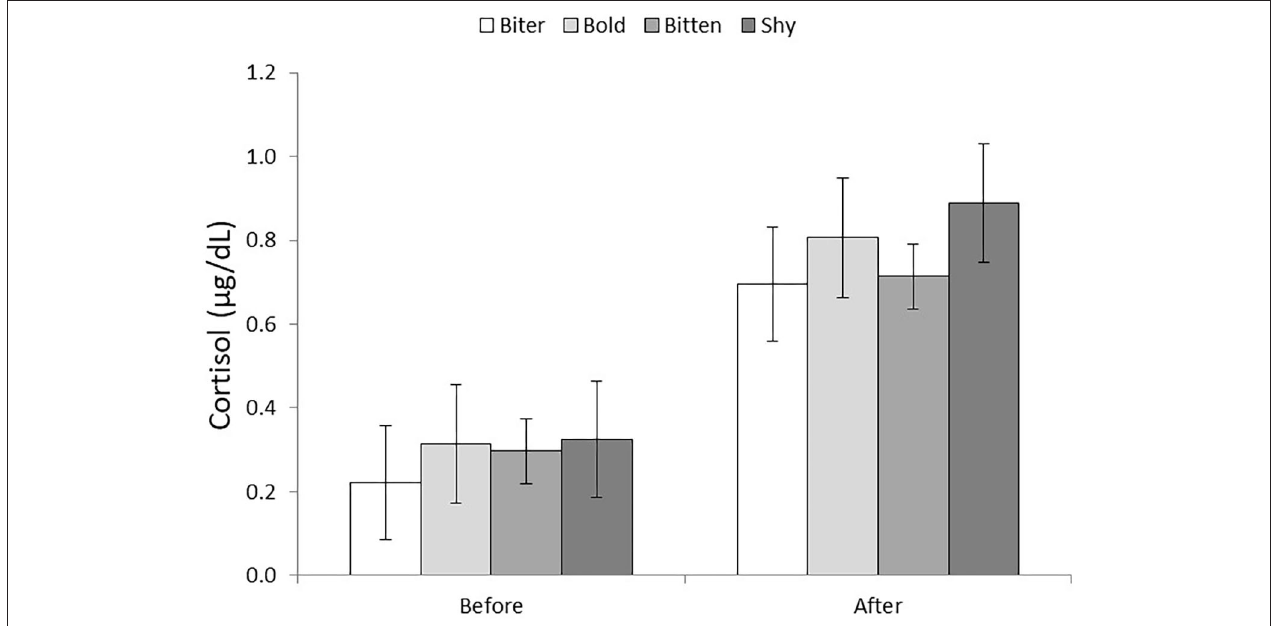
FIGURE 2 | Salivary cortisol levels ( µ g/dl) of the four pig types (BITER, BOLD, BITTEN, SHY) before and after the open field and novel object